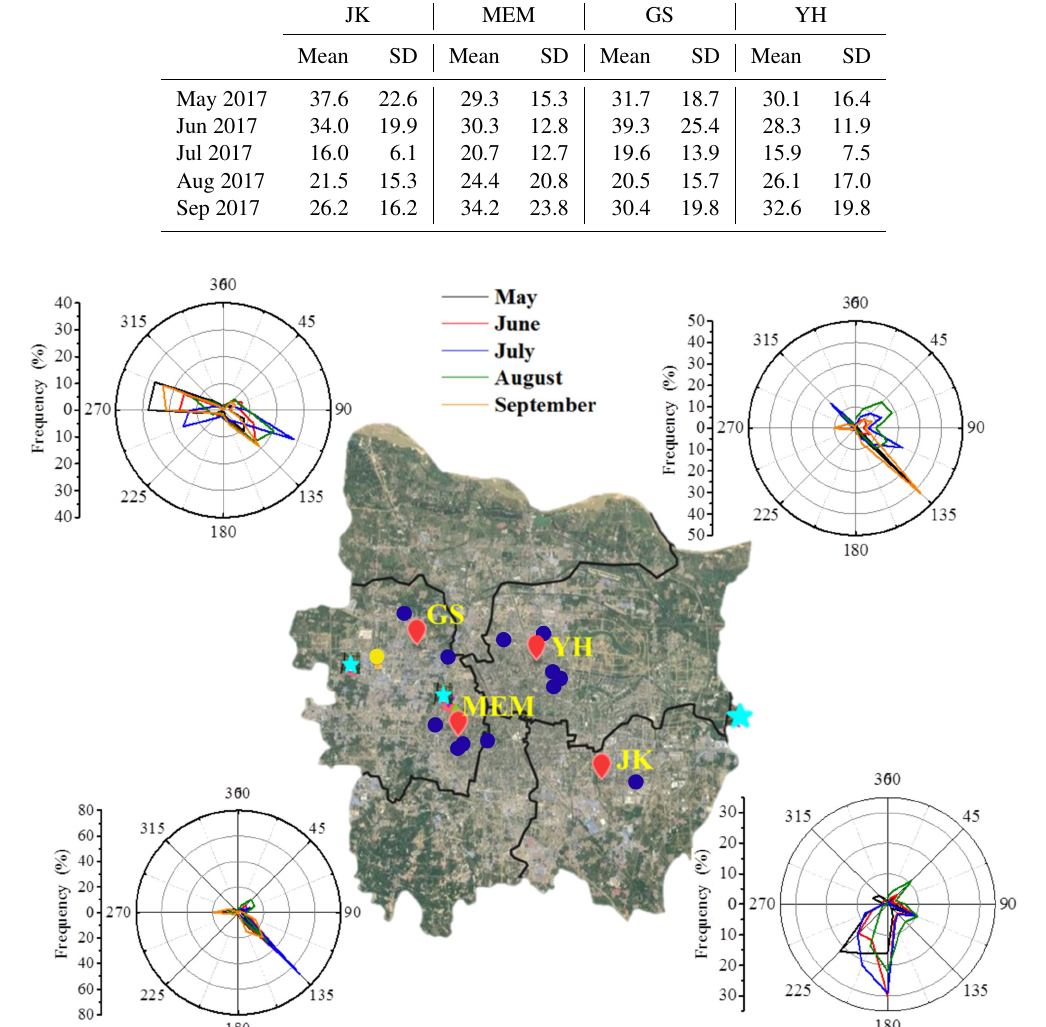
Table 1. Mean concentrations of (cid:54) VOCs (ppbv) and correspondent standard deviations (SDs) at every site during the sampling period.